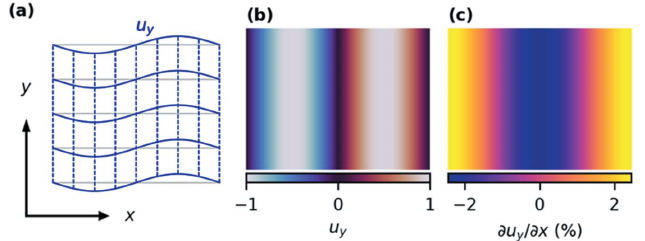
Figure 1 Schematic of the displacement and its gradient. ( a ) A schematic representation of a displacement field inside a crystal (blue) with respect to an unperturbed crystal lattice (gray). The momentum transfer Q is parallel to the y -axis, and the experiment is insensitive to the vertical crystal planes (dashed lines). ( b ) The 2D displacement field u y ( x , y ) in false color, typically directly extracted from BCDI data through phase retrieval. We chose the field such that the normal strain @ u y / @ y = 0. ( c ) The displacement gradient @ u y / @ x in the direction perpendicular to Q clearly shows the bending of the planes visible in ( a ). In ( b ) and ( c ) the x and y coordinates are identical to those in ( a ).